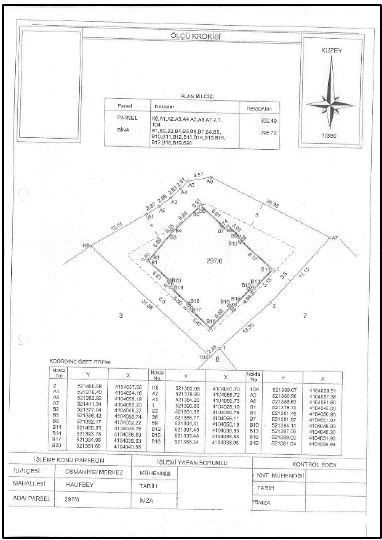
Figure 6. Surveying chart sample form Osmaniye,